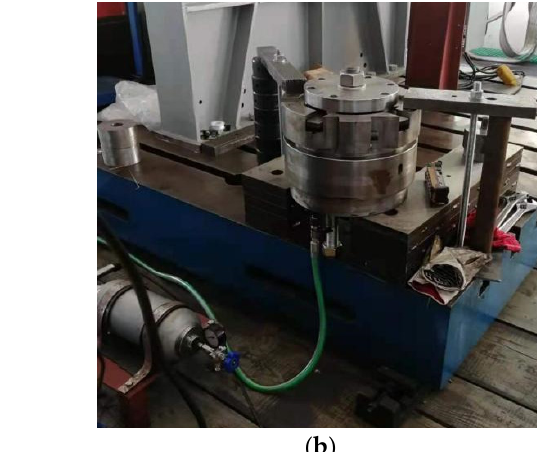
Figure 4. Test device of frictional force: ( a ) schematic diagram; ( b ) photograph.